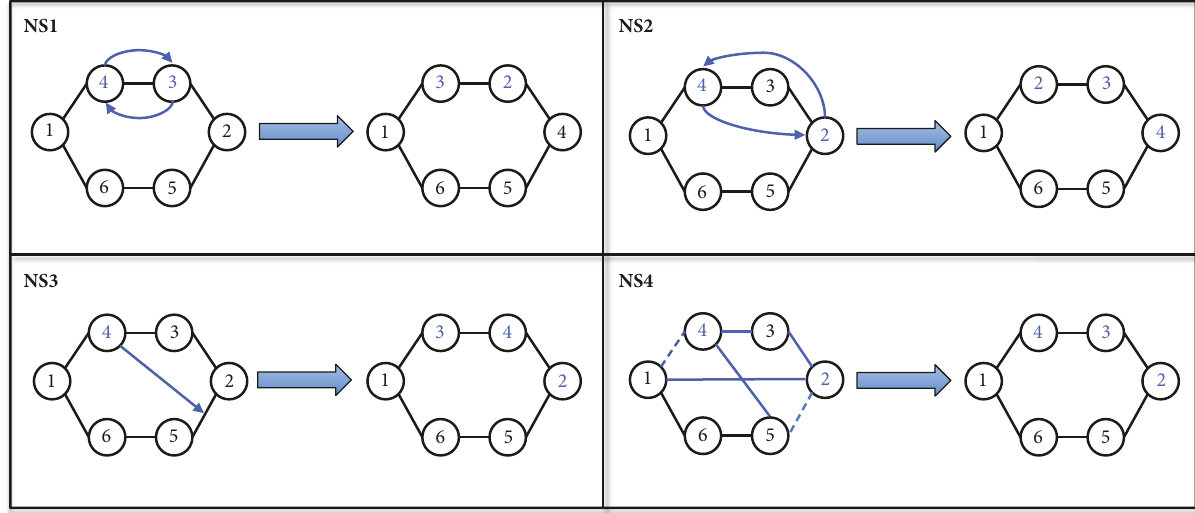
Figure 1: NS1, NS2, NS3, and